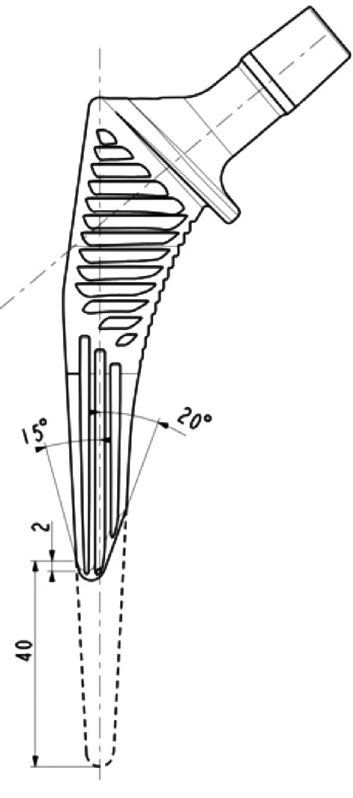
Figure 1. Design of the Targos stem size 9 with the shape of the standard stem and the shortened stem.